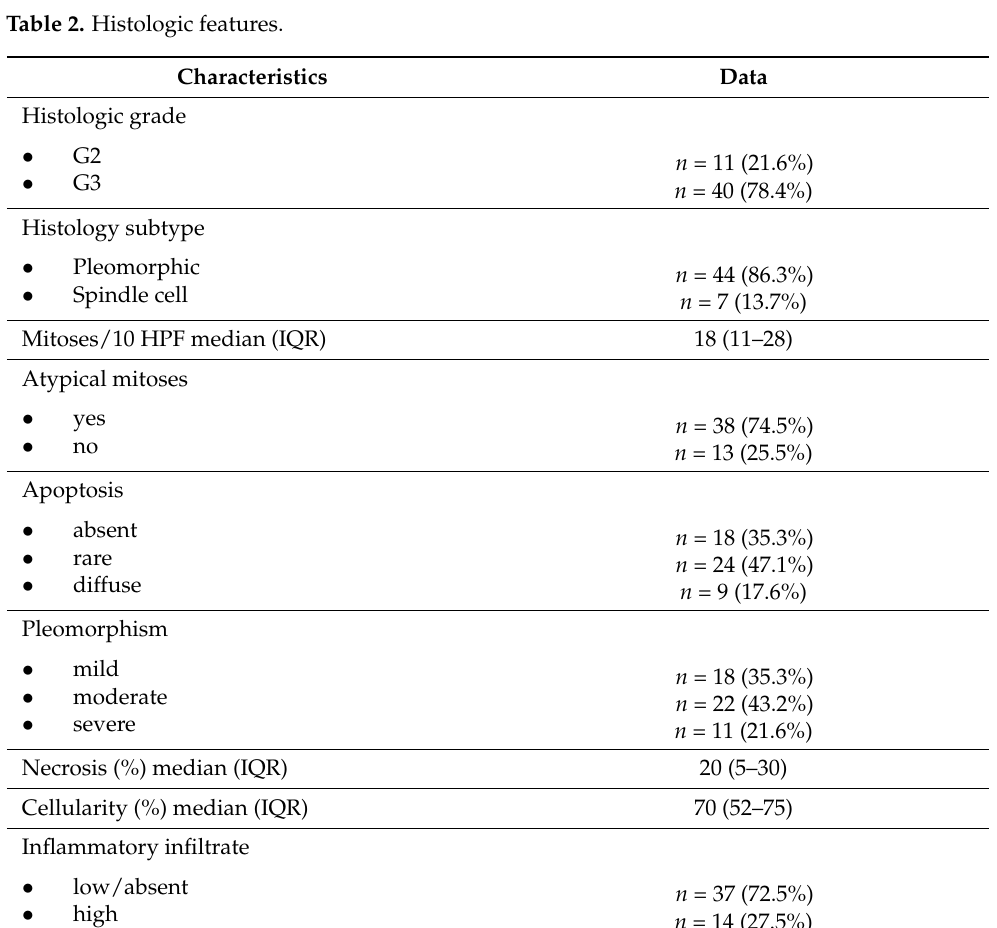
Table 2. Histologic features.